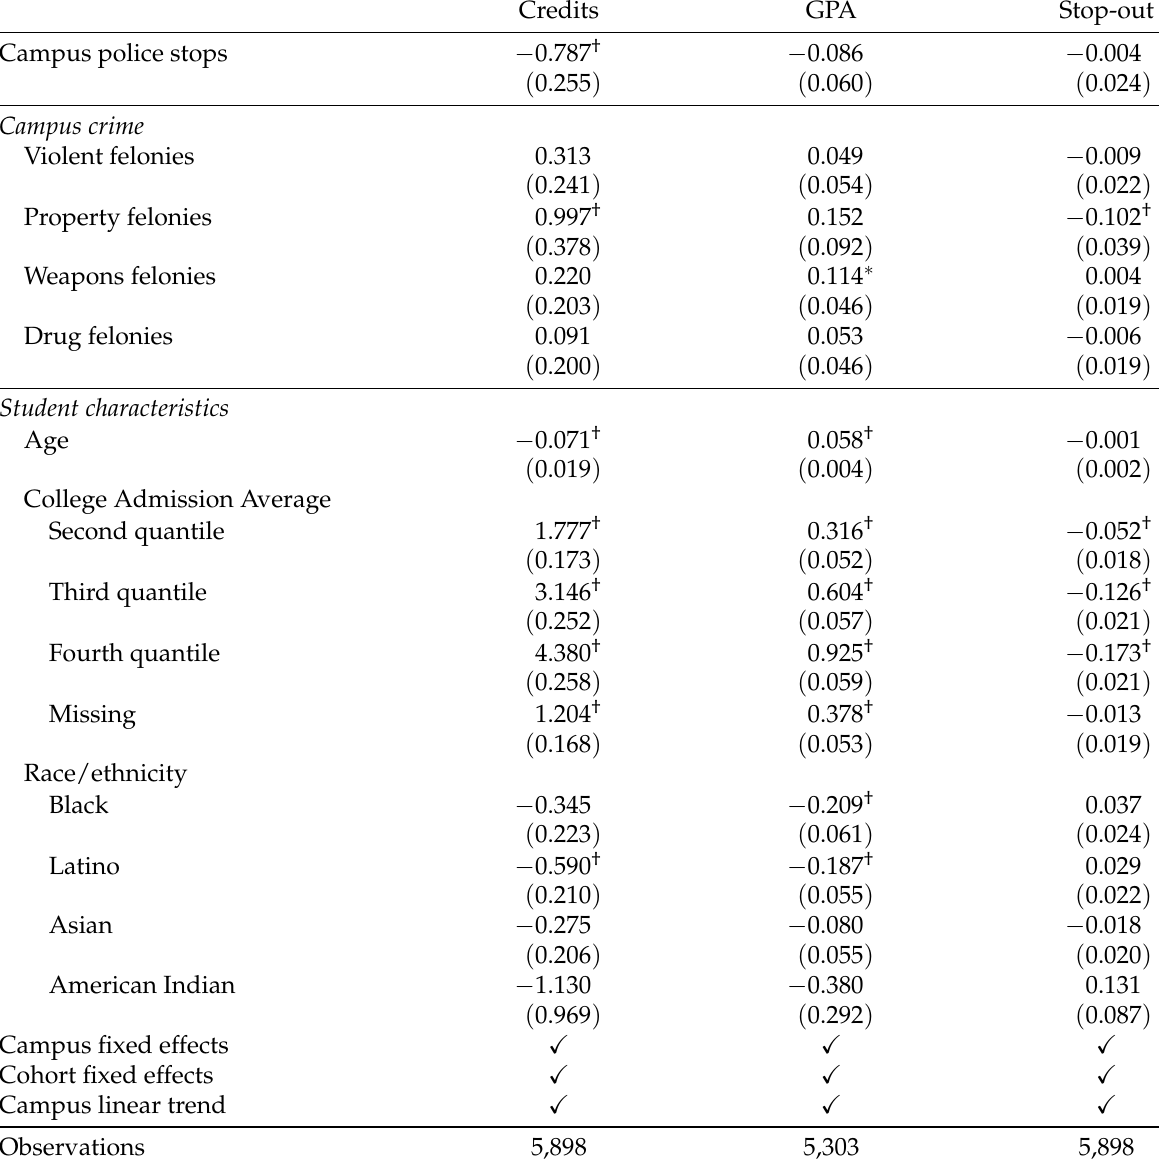
Table 2: Effect of police stops on course credits, GPA, and stop-out for undocumented